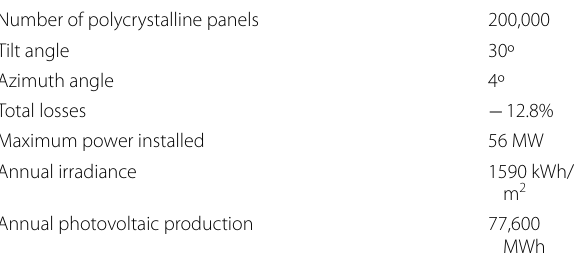
Fig. 7 Annual wind energy production on São Miguel island